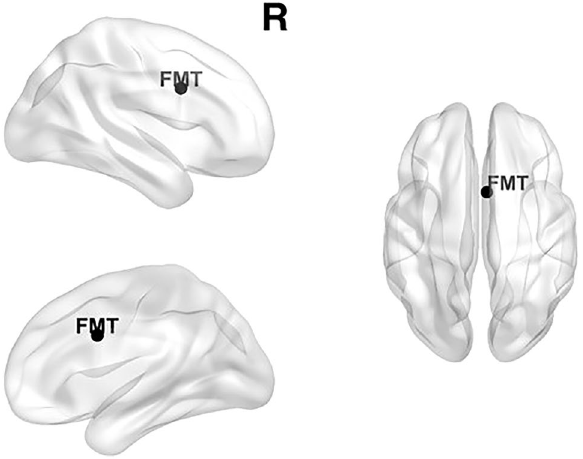
Figure 1. Localization of frontal midline theta (FMT, 4–7 Hz) based on the 22 individual components. MNI coordinates: X = 4.2 Y = 7.9 Z = 30.8. The brain networks were visualized with the BrainNet Viewer 70